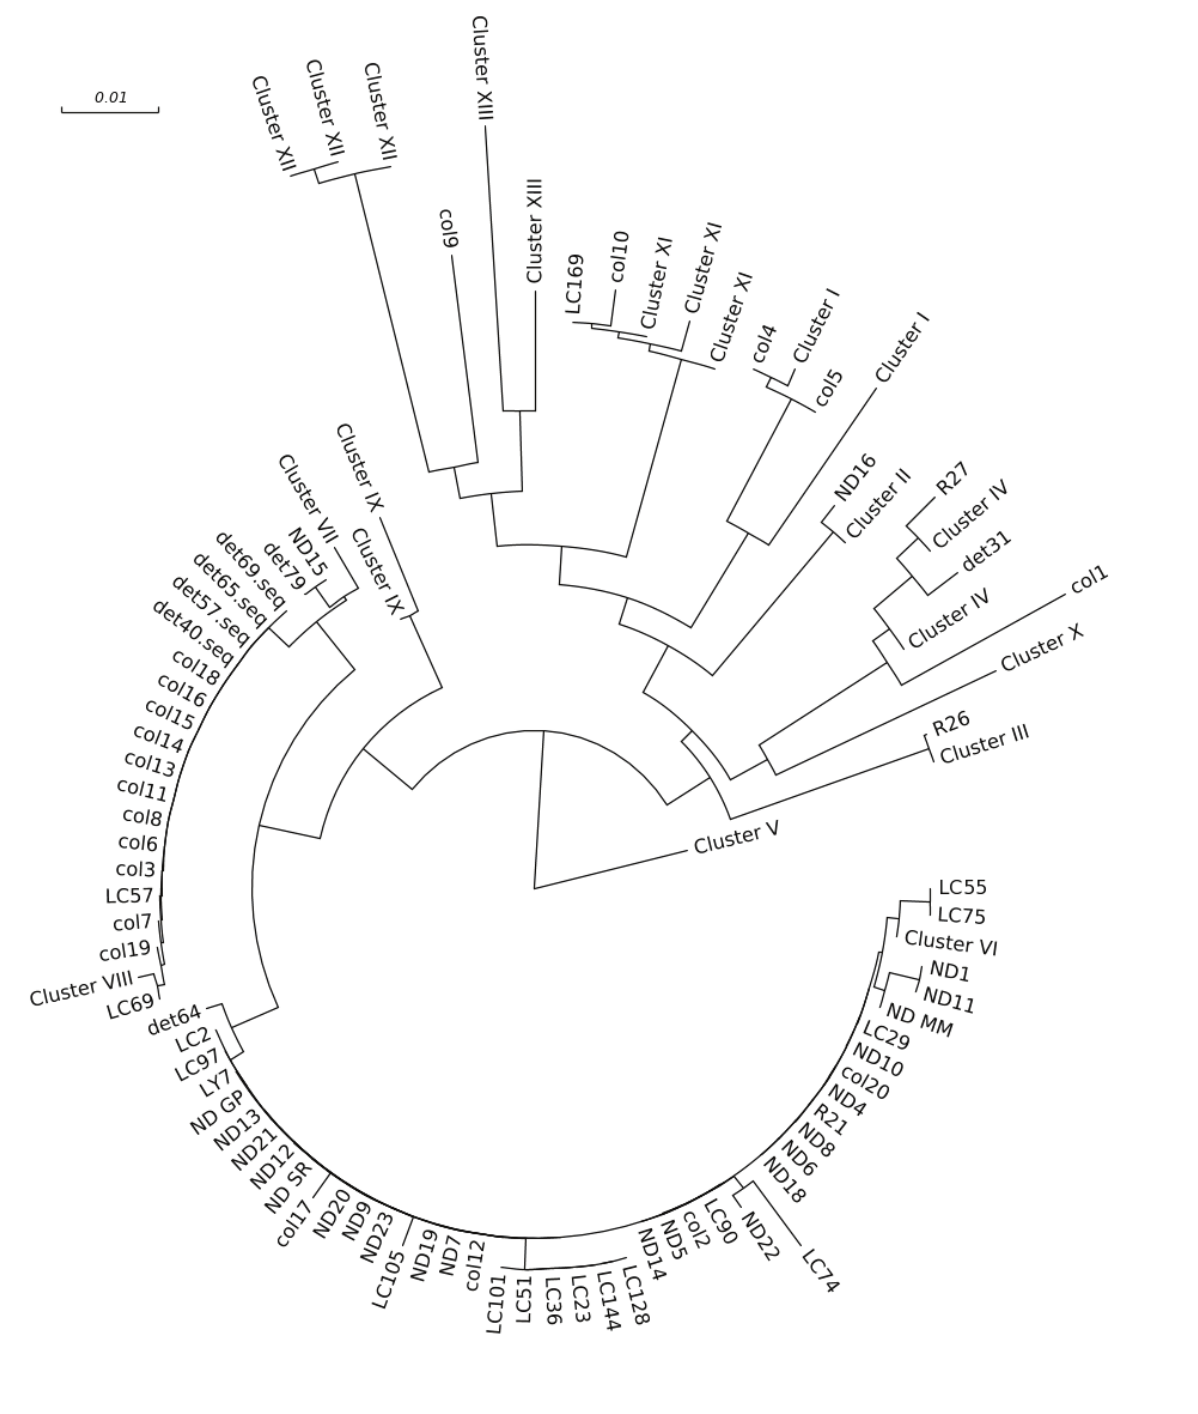
Figure 2. Phylogenetic tree by hsp60 sequencing with classification by